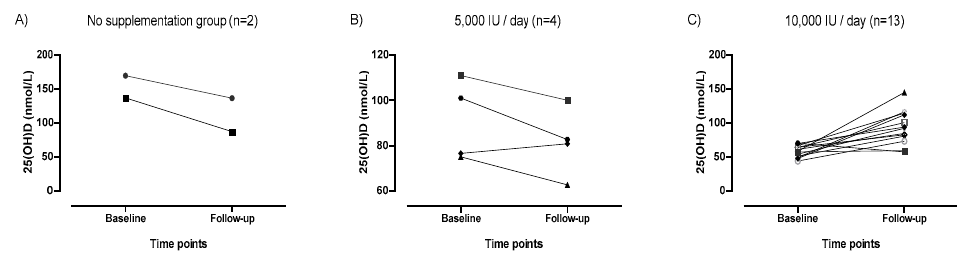
Figure 2. 25(OH)D concentrations at baseline and follow-up by group and individual.